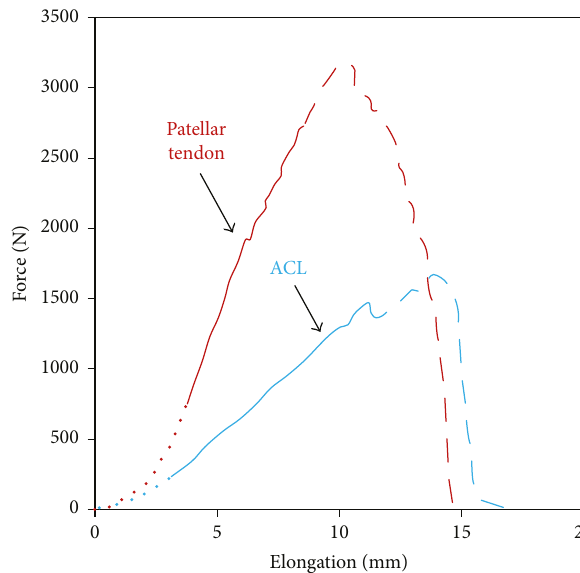
Figure 4: Tensile strength of ACL and the patellar tendon [33]. The dotted lines represent the toe region, continuous lines represent the linear region, and dashed/broken lines represent the yield